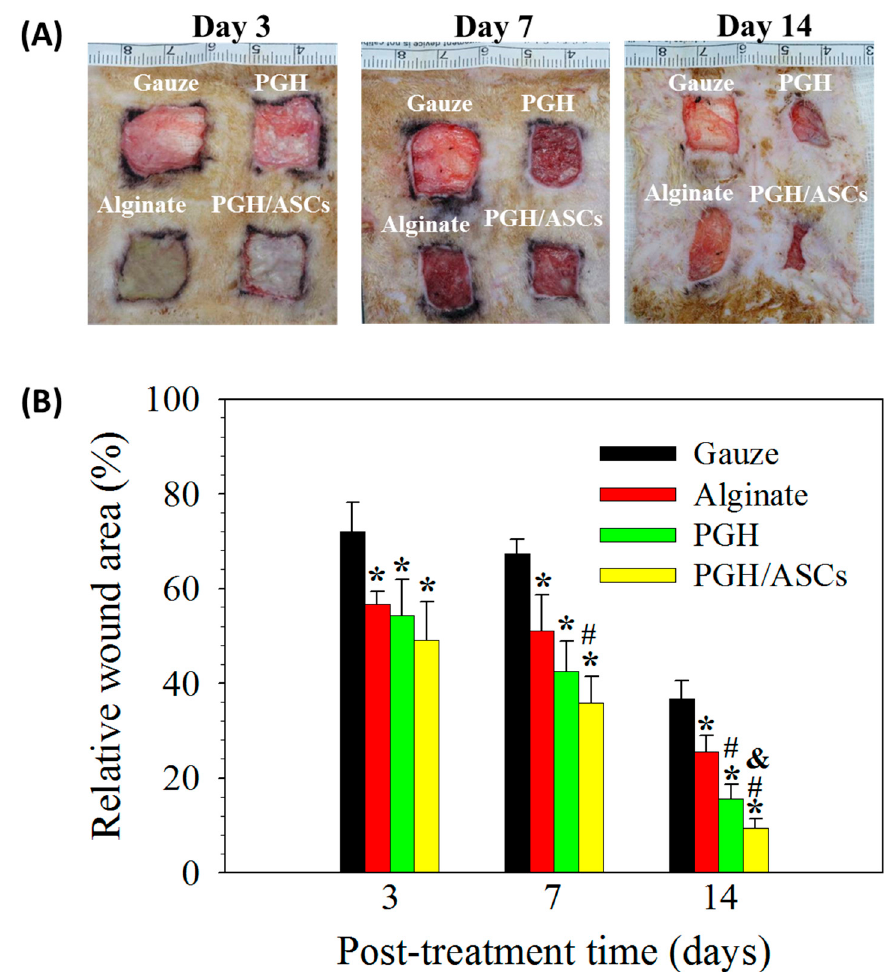
Figure 7. ( A ) The representative gross view images of wounds in SD rats on days 3, 7, and 14 after treatment with gauze, alginate wound dressing, PGH, or PGH/ASCs. ( B ) The relative wound area for each treatment was determined from the traced wound border covered with epithelia and normalized to the initial wound area on day 0 ( n = 4). * p < 0.05 compared with gauze, # p < 0.05 compared with alginate, & p < 0.05 compared with PGH.